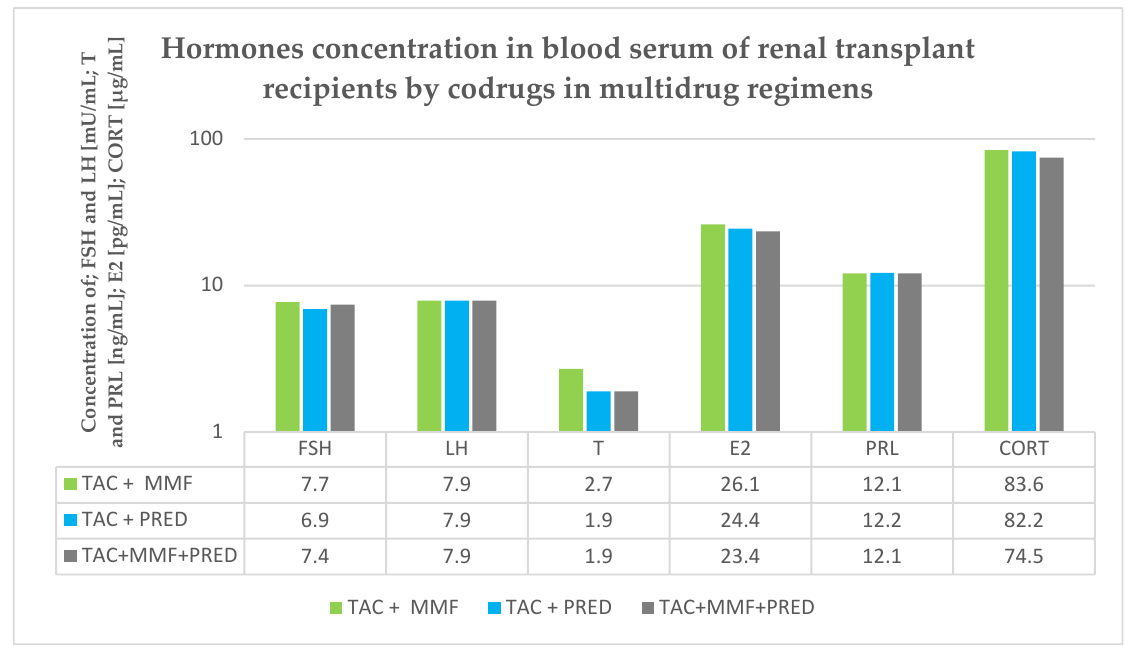
Figure 2. Hormones concentration in blood serum in renal transplant recipients by codrug in multidrug regimens.